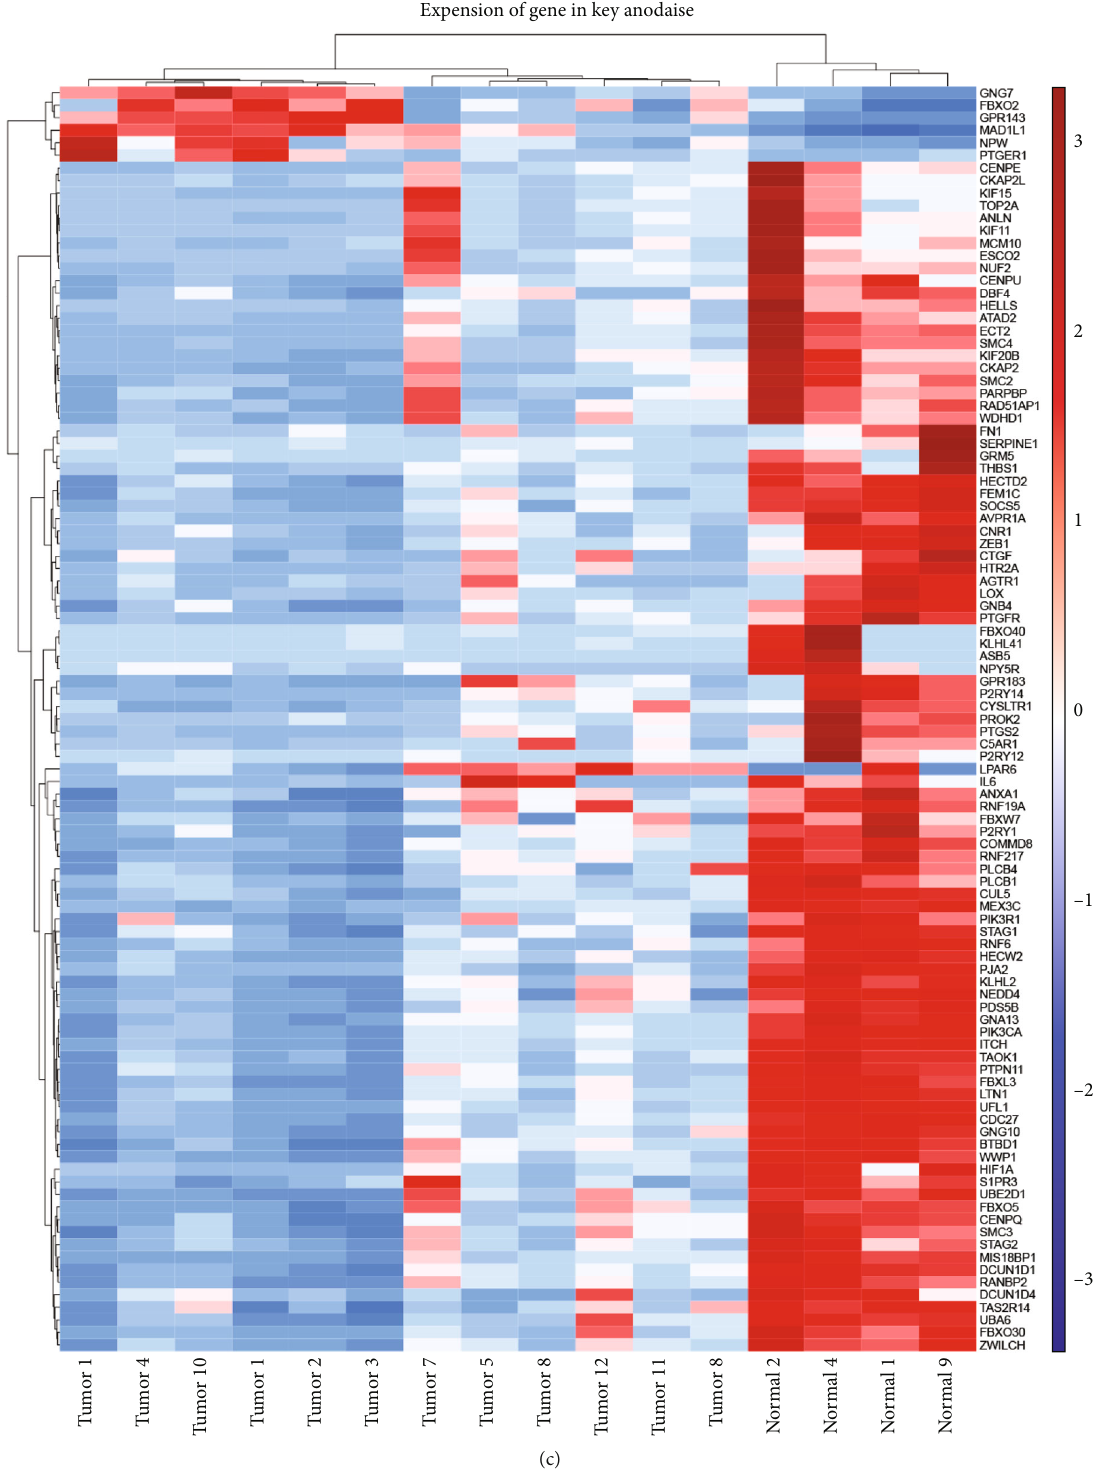
Figure 2: PPI network construction and key module detection. (a) PPI network of the DEGs created using Cytoscape. The genes of the key module are in yellow, whereas the other DEGs are in blue. (b) Key module identi fi ed using the MCODE plug-in of Cytoscape. The key module possesses the most frequent and closest interactions in the PPI network. (c) Heatmap and cluster analysis of key module genes. Red and blue depict relative gene expression levels from high to low. Heatmap scale: row; cluster method: ward; D2; row distance measure: Euclidean; row distance measure: Euclidean. PPI: protein – protein interaction; DEGs: di ff erentially expressed genes; MCODE: molecular complex